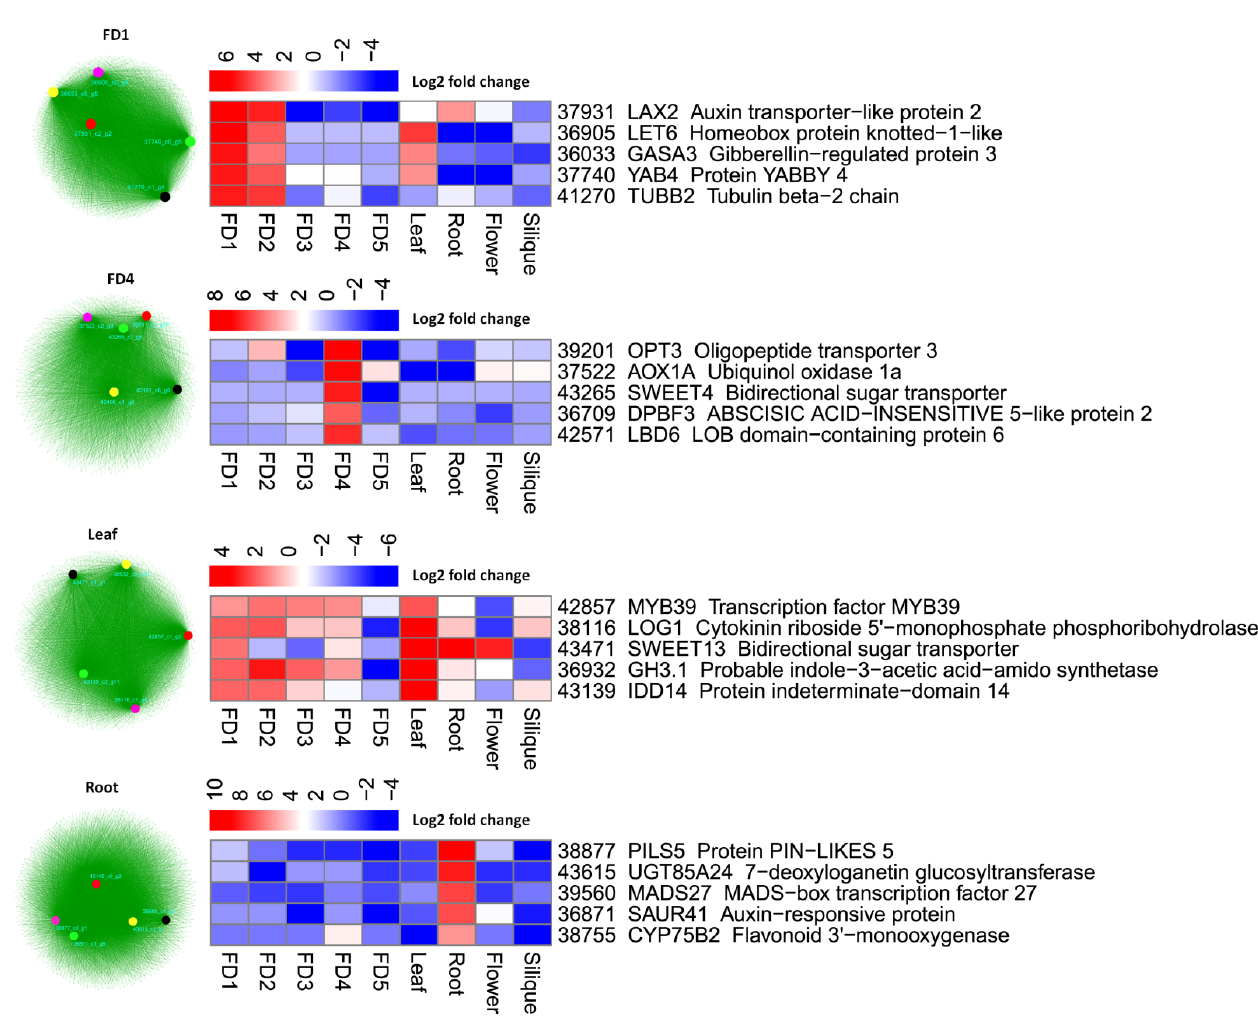
Figure 7. WGCNA-based clustering and identification of highly significant hub genes from each cluster. The heatmaps show the transcriptomic expressions of selected hub genes.